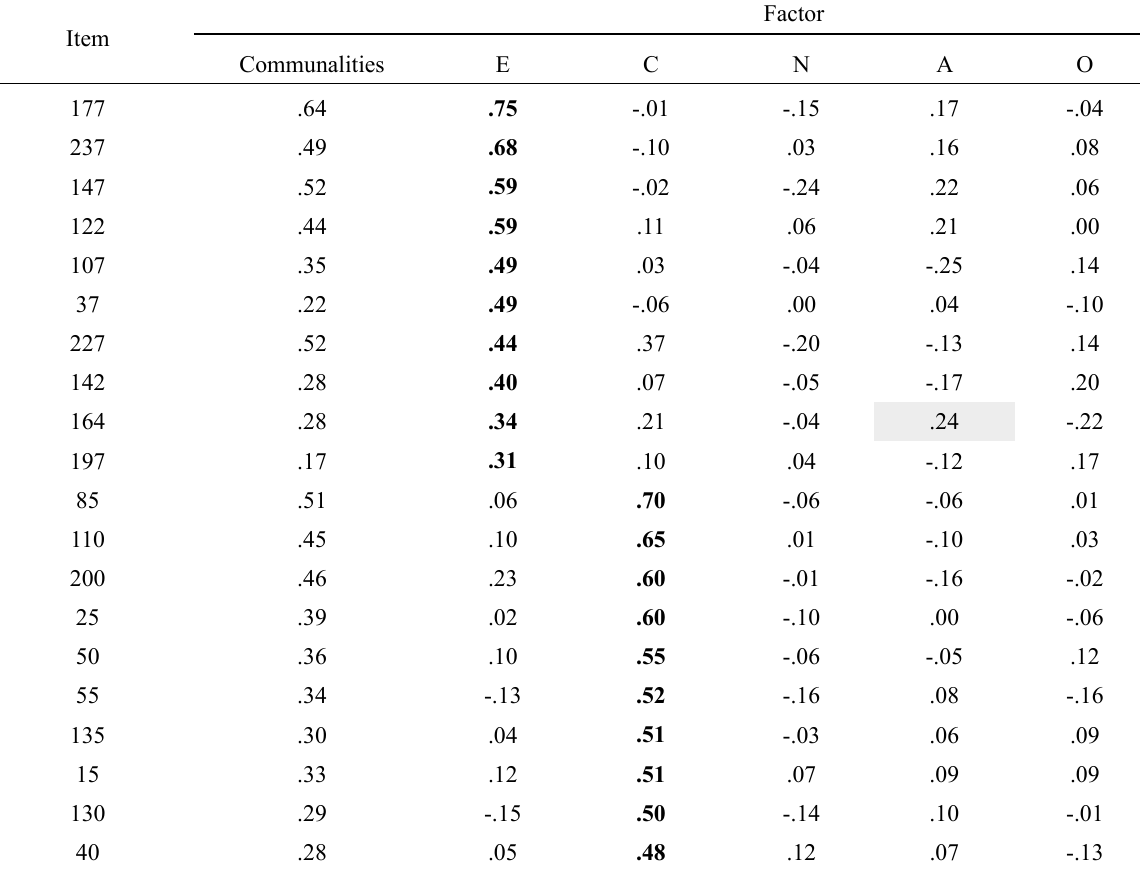
Principal Axis Factoring with Direct Oblimin Rotation Solutions of NEO-FFI Items